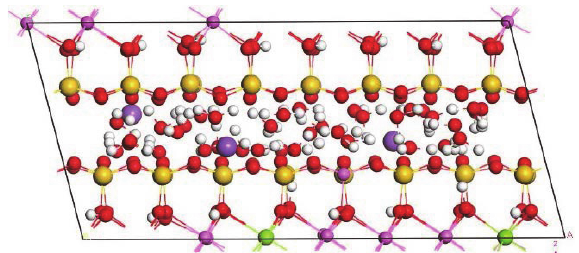
Figure 2: Schematic representation of the clay/water unit cell. The production calculation uses a supercell of 64 unit cells. Notice the location of the tetrahedral and octahedral substitutions. Color code: yellow: silicon; red: oxygen; magenta: aluminum; green: magnesium; white: hydrogen; blue: